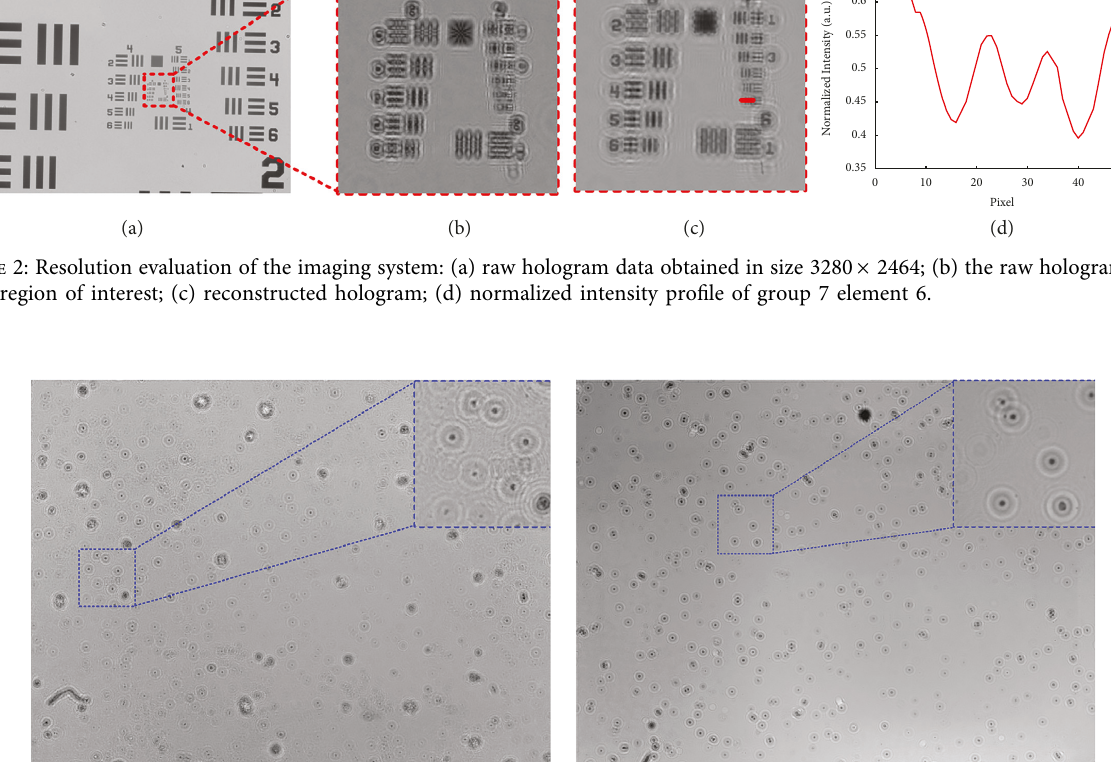
z 1 distance 6cm.